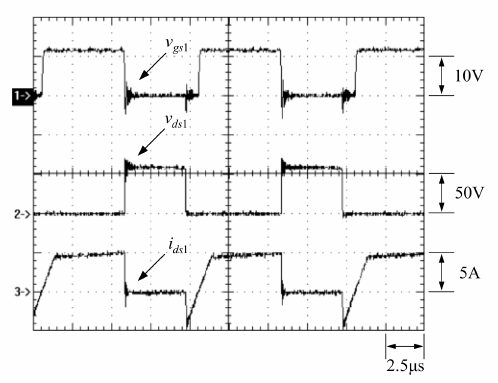
Figure 16. Experimental waveforms: (1) v gs 1 ; (2) v d s1 ; (3) i d s1 .